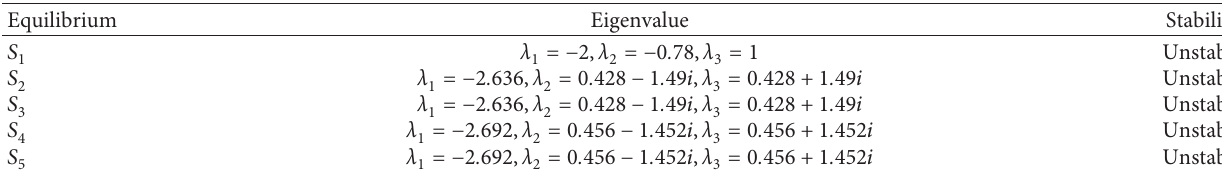
Table 2: Stability of equilibrium points of